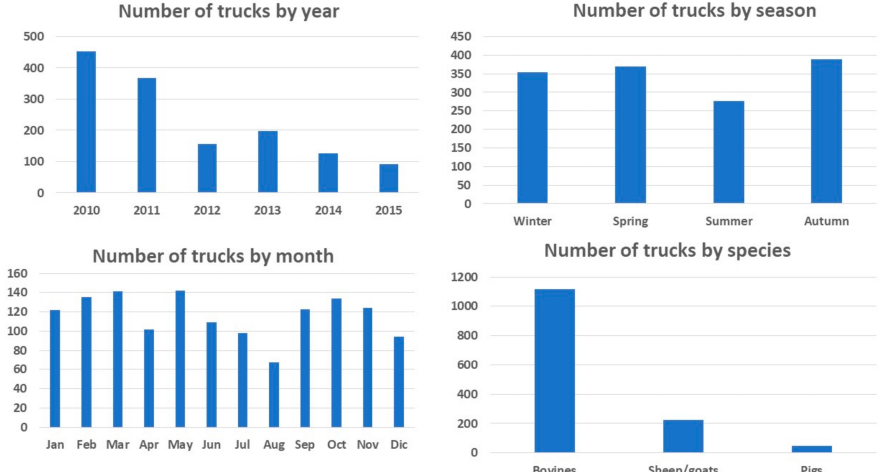
Figure 1. Descriptive statistical analysis of the 1391 trucks which stopped at control post CE 07/PS Bitritto (Bari, Italy) from 2010 to 2015. Number of trucks examined by categorical variables (i.e., factors) year, season, month, and species.